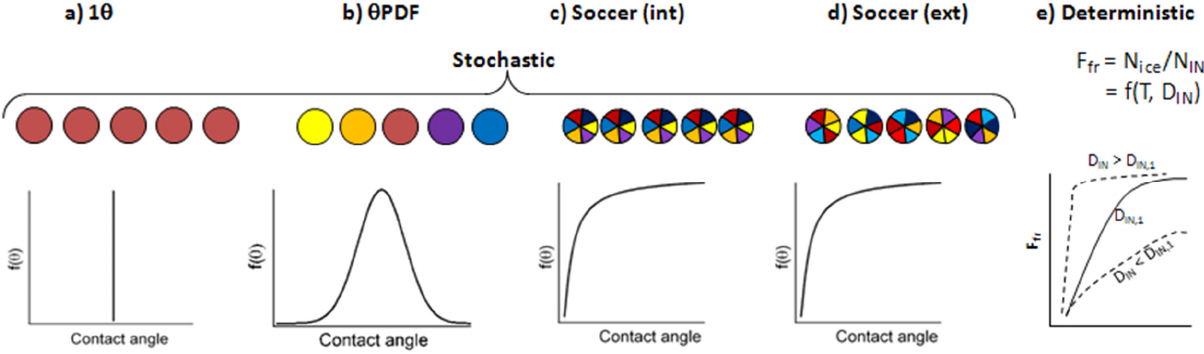
Figure 1. Nucleation schemes that have been developed to describe freezing of kaolinite (Lüönd et al., 2010). Parameters to describe the θ distributions and temperature dependence of F fr are summarized in Table 1.